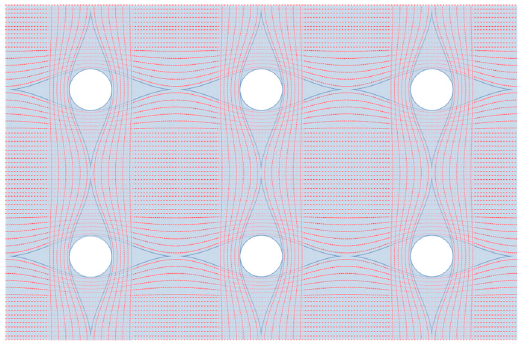
Figure 5 . Controlled fiber placements for a rectangular based perforation arrangement in a [0/90]s composite laminate.